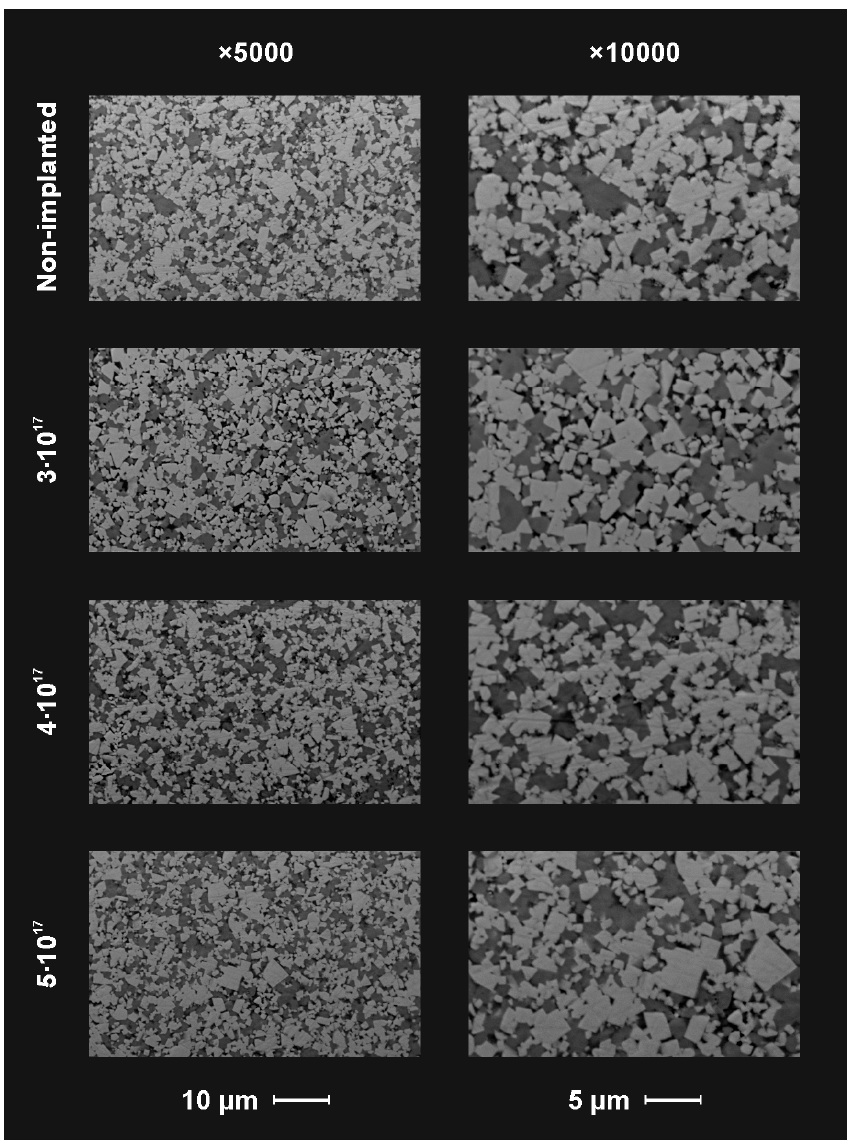
Figure 4. SEM observations of the nonimplanted and implanted with 3 fluencies on the surface of the guide pad material.